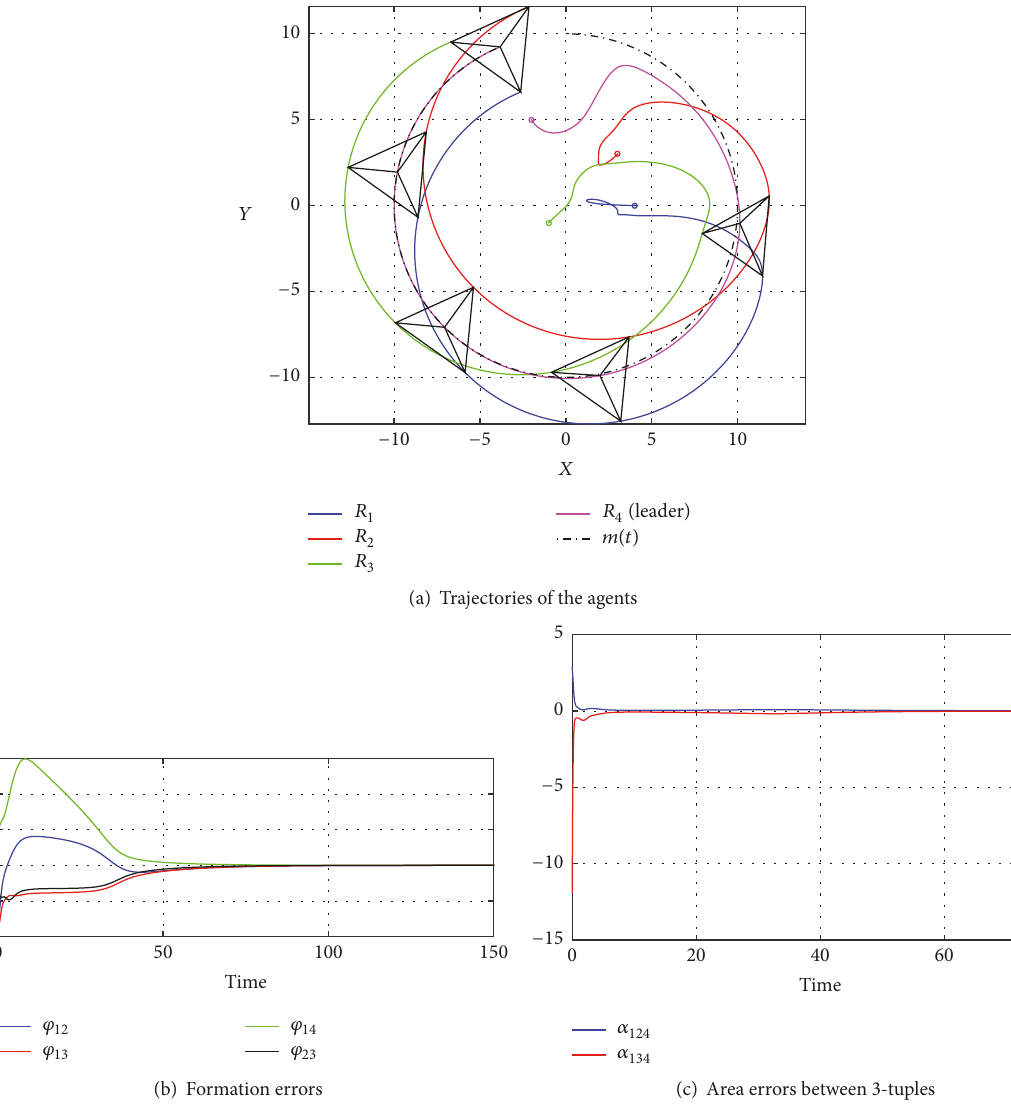
Figure 7: Simulation 2 results of distance and area formation control with 𝑛 = 4 , 𝑛 1 = 2